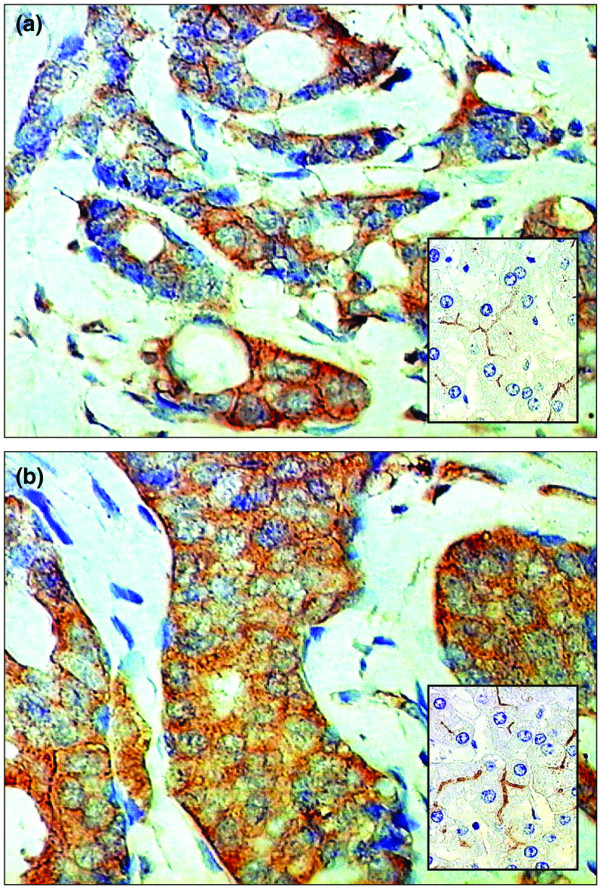
Immunohistochemical localization of MDR1/P-glycoprotein (red). (a) With antibody C219 in breast cancer (showing cytoplasmic and membrane localizations in cancer cells) and healthy human liver (inset) (hematoxylin, ×400). (b) With antibody JSB-1 in breast cancer (showing cytoplasmic and membrane localizations in cancer cells) and healthy human liver (inset) (hematoxylin, ×400).